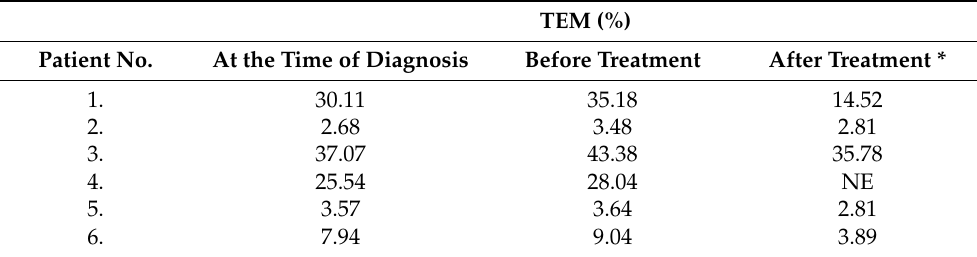
Table 2. TEM percentage in CLL patients over time. Each row in a table represents a set of related data for an individual